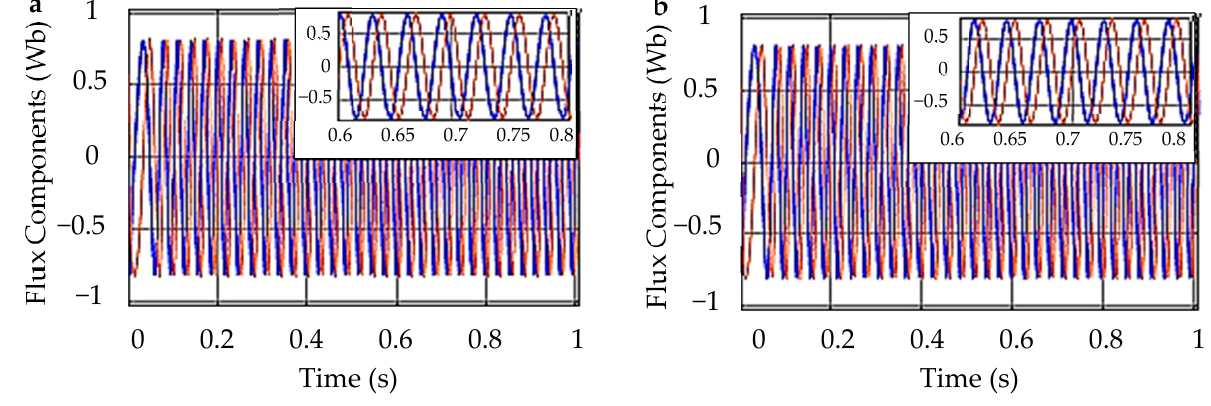
Figure 15. Flux components under load during startup and steady state.